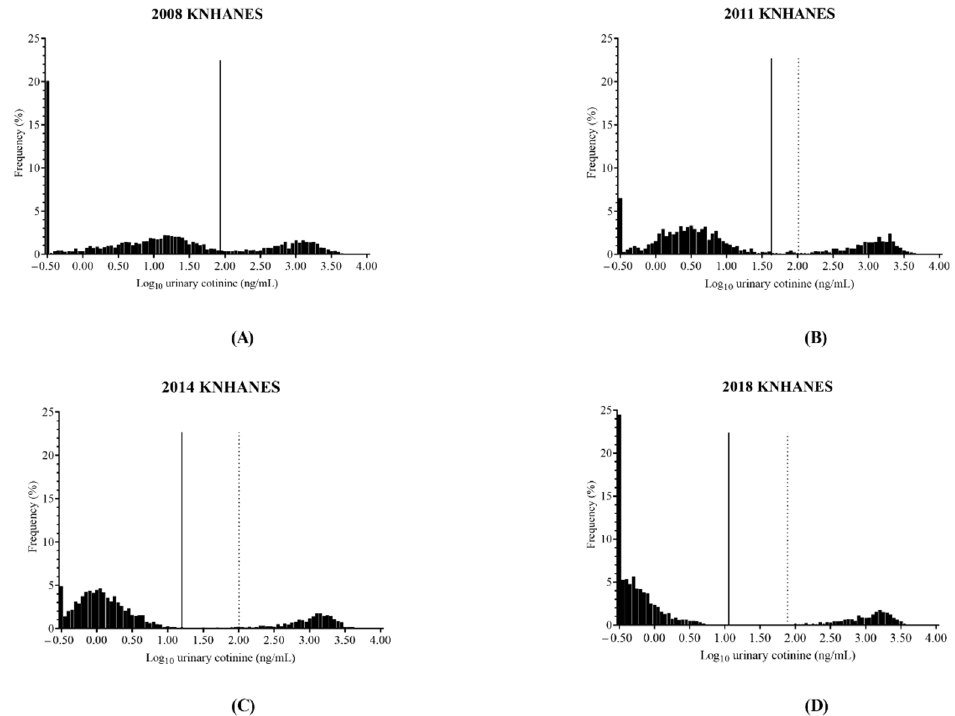
Figure 2. The distributions of urinary cotinine concentration from total participants and established optimal cut-off values for smoking status classification. 2008 KNHANES ( A ), 2011 KNANES ( B ), 2014 KNANES ( C ), and 2018 KNANES ( D ). The vertical solid lines represent the optimal cut-off values of urinary cotinine concentration to distinguish current smokers from nonsmokers in each dataset. The vertical dotted lines represent the optimal cut-off values of urinary cotinine concentration to distinguish daily and non-daily smokers in each dataset. Only the optimal cut-off value of urinary cotinine concentration for distinguishing current smokers from nonsmokers was established in the 2008 KNHANES dataset. KNHANES = Korean National Health and Nutrition Examination Survey.